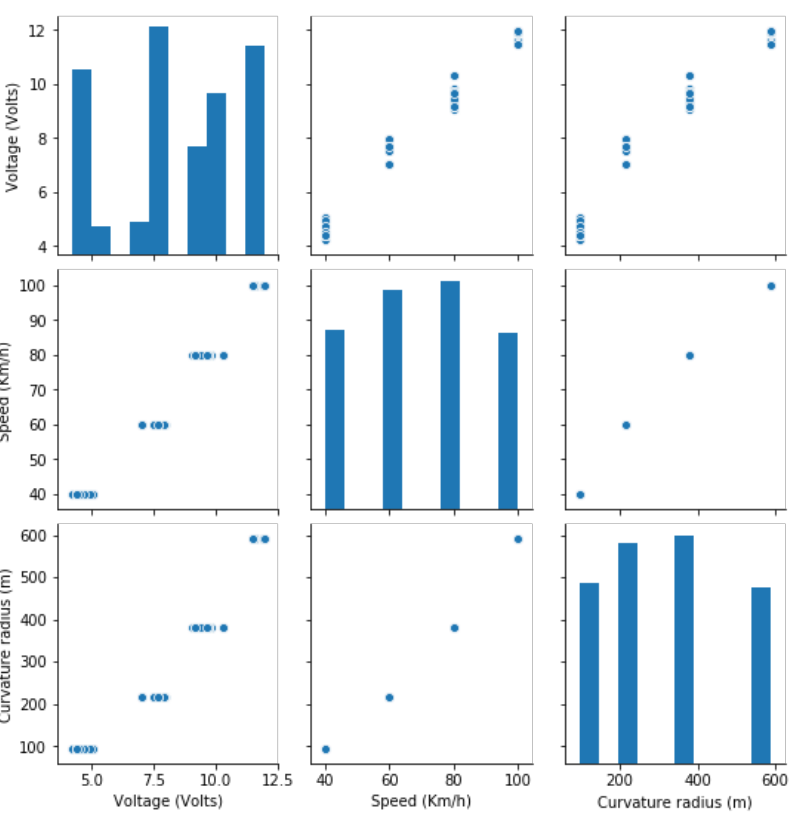
Figure 11. Pair plot of the used variable.